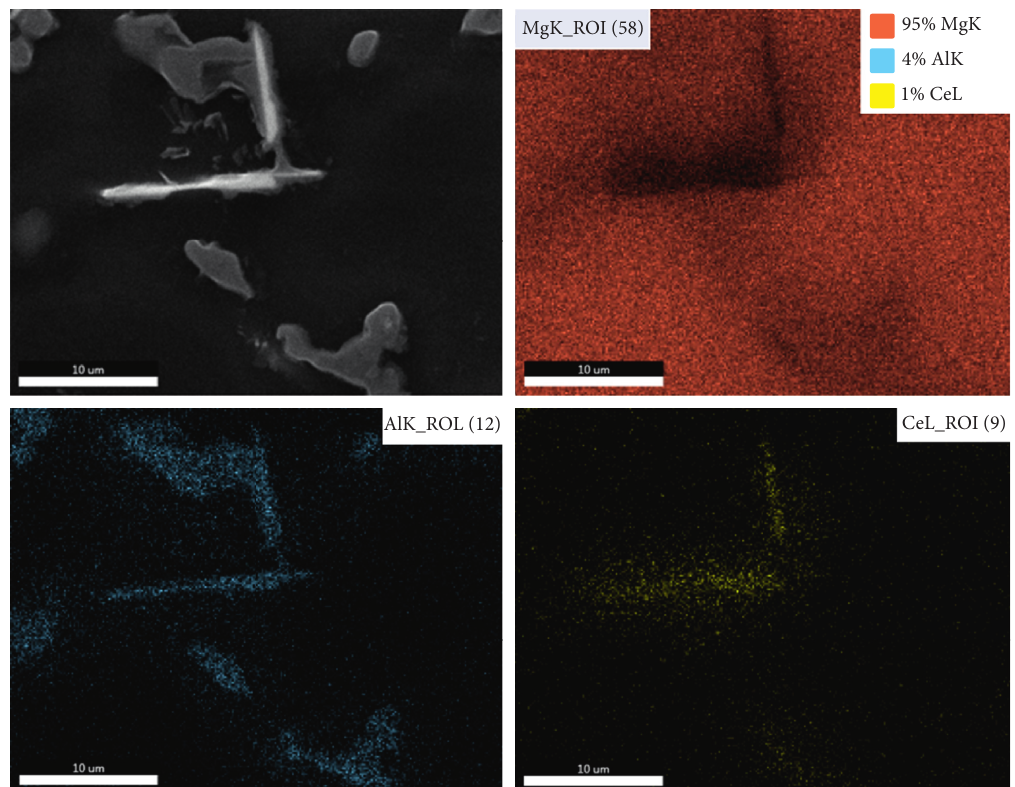
Figure 4: SEM and EDX analysis of AZ91D +1.0wt.% Ce +1.0wt.%